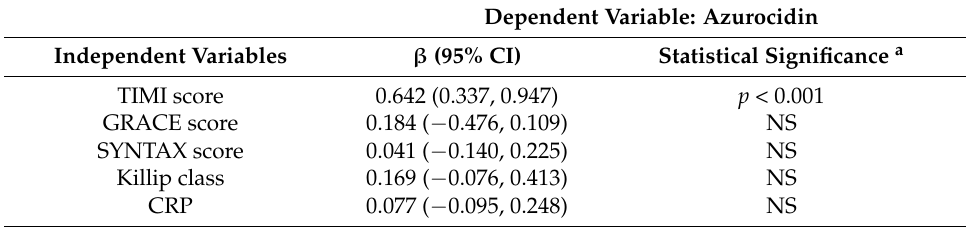
Table 3. Multivariate linear regression analysis to evaluate the association between azurocidin levels and independent variables identified in the univariate linear regression